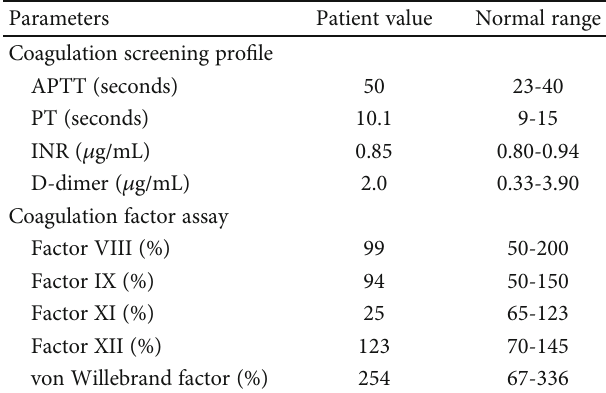
Figure 1: A red-colored rash was observed on both